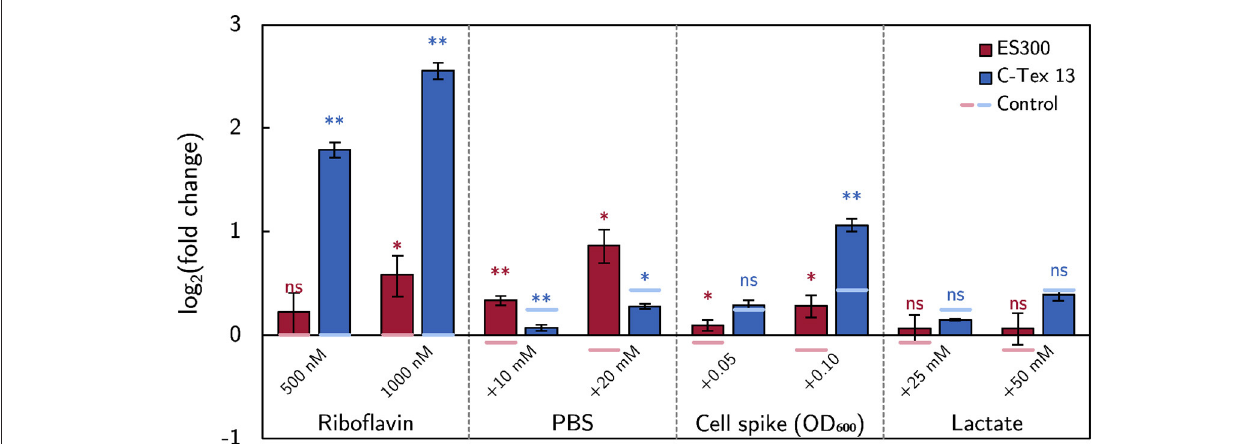
FIGURE 5 | The effect of the medium components on the current production. The effect size is measured as fold change of the current production. The asterisks indicate significance levels: p < 0.01 (**), p < .05 (*), p ≥ 0.05 (ns). The significance levels of the spike experiments were calculated against the control without spikes ( Supplementary Figure 5 ) and the effect of riboflavin against the current production without riboflavin ( Figures 3A,B ). The numerical values can be found in Supplementary Table 4 .